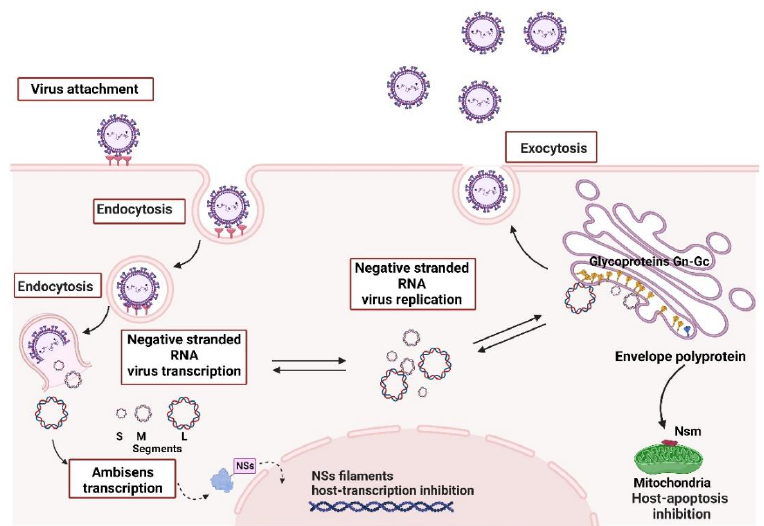
Figure 5. Replication process of Orthobunyavirus and Phlebovirus . The virus enters the cells through clathrin-mediated endocytosis, and endosome membrane fusion occurs at acidic pH facilitated by viral glycoproteins, uncoating and liberating the viral RNA into the cytoplasm. The viral polymerase L and the N protein catalyze transcription and replication of the viral genome in the cytoplasm. Translation and transcription are coupled processes due to the action of translocating ribosomes, which are able to prevent nascent mRNA interactions and premature termination, allowing transcription to occur up to the termination signals at the 5′ end. In replication, antigenomic RNAs (cRNAs) are synthesised and used as templates for progeny genomic RNAs (vRNAs). The non-structural NSs and NSm proteins have been proposed to shut down host transcription and apoptosis for efficient viral replication. Interaction of the viral glycoproteins Gn and Gc in the Golgi apparatus allows packaging of the RNP complex into the viral particles. Further modifications and maturation steps occur until the new virions are released from the cells. Based on: Guu, Zheng and Tao (2012) [72]. Created with BioRender.com (Accessed on 11 September 2022).